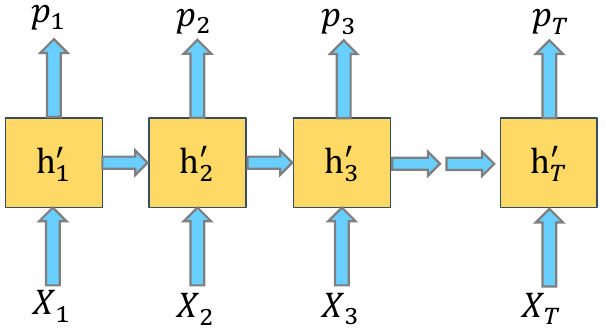
Figure 2. Auxiliary network.